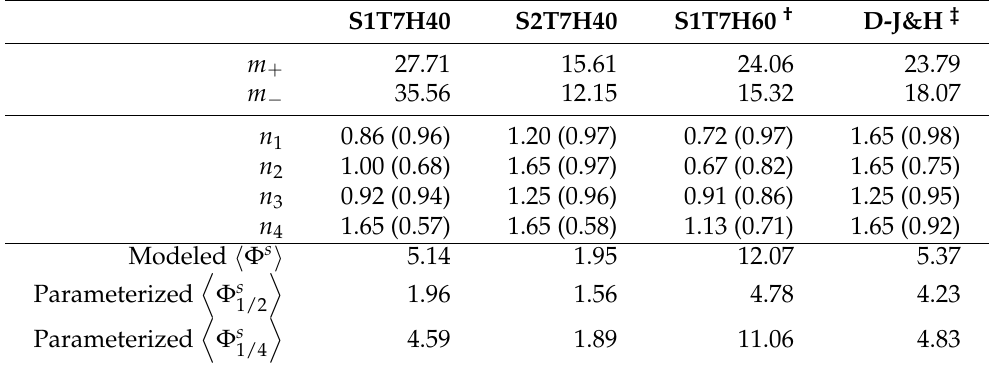
Values in the parentheses represent R 2 coefficients of determination. † Model results from [46]. ‡ Model results from [43].